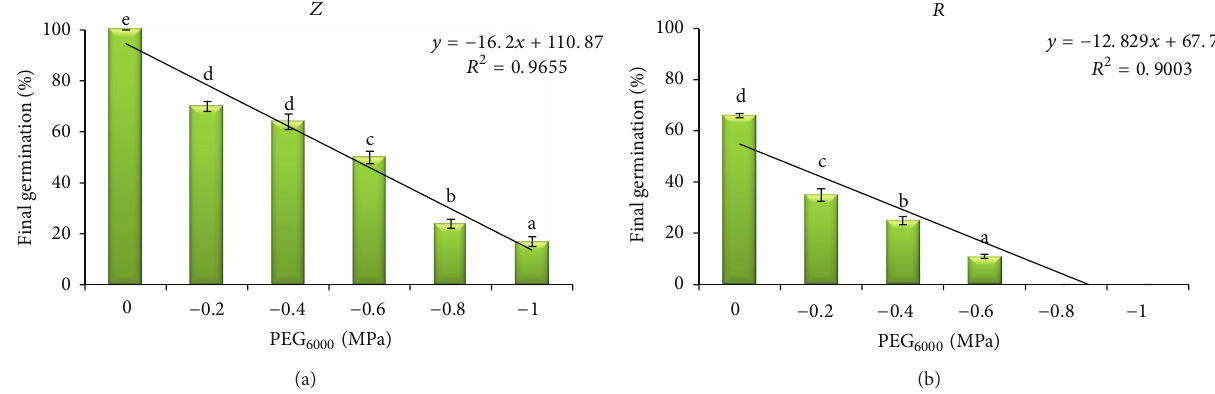
Figure 3: Variation of the final germination percentages (%) of Ziziphus lotus ( 𝑍 ) and Rhus tripartitum ( 𝑅 ) seeds at different PEG 6000 solutions of different osmotic potentials (0 to − 1MPa) ( 𝑛 = 5 ).